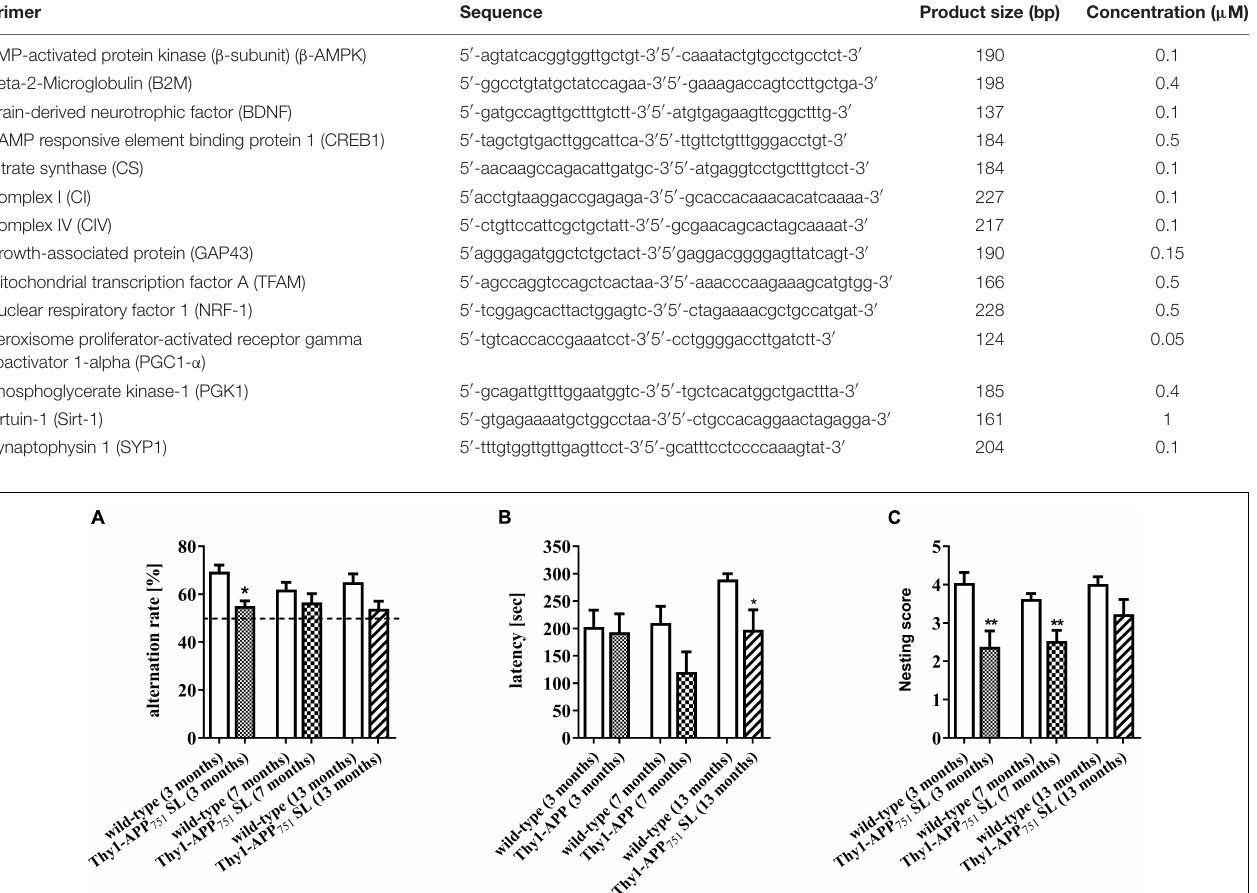
TABLE 1 | Oligonucleotide primer sequences, product sizes and primer concentrations for quantitative real-time pcr; bp: base pair. Primer Sequence Product size (bp) Concentration ( µ M)